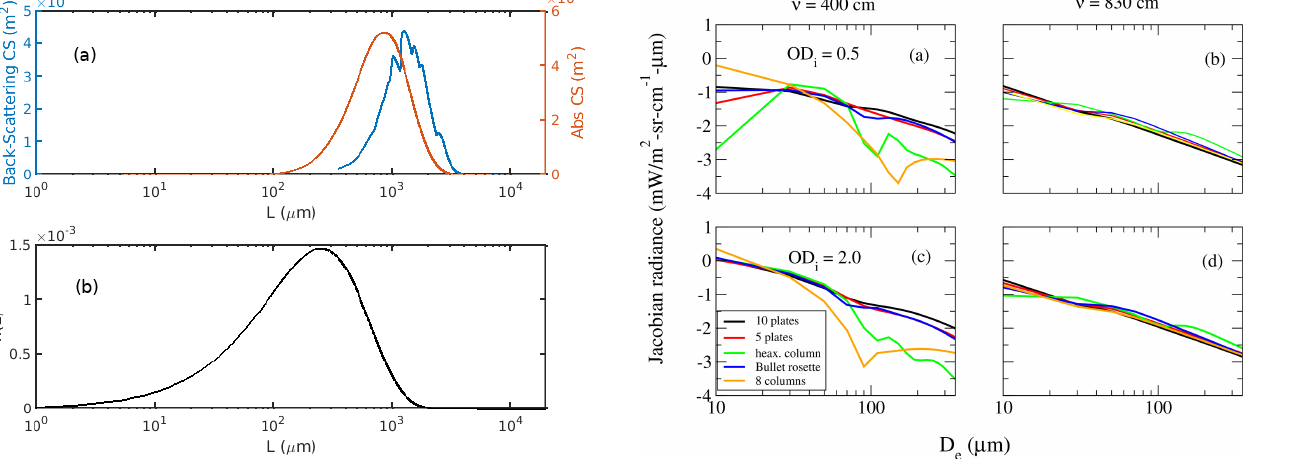
Figure 4. Left side: normalized PSD with L m = 1000µm (b) and the relative backscattering cross section at 24GHz and absorption cross sections at 400cm − 1 as a function of particle dimensions (a) .